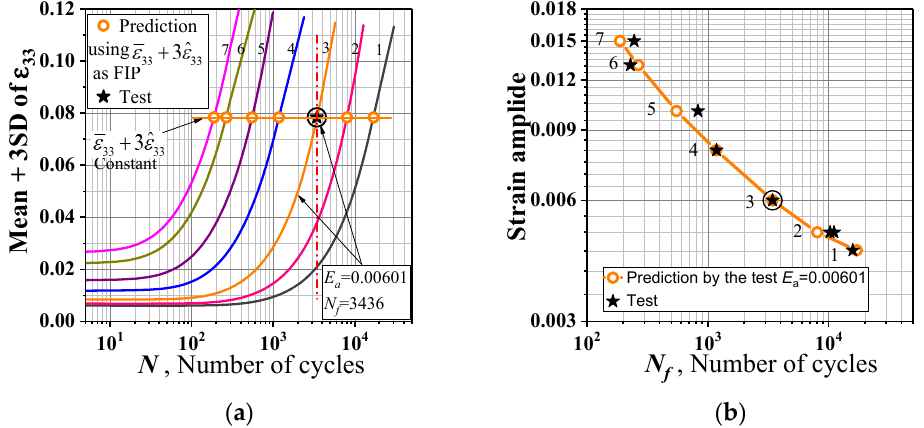
ε , by the intersection between curve of ˆ3 ε ε+ ( E = , by the intersection between curve of ε 33 + 3ˆ ε 33 33 33 33 33 a N E , by , E a ) , f f a ˆ3 0.078 ε ε+ = ; ( b ) predicted fa- 33 33 Test Upper prediction Lower prediction Prediction by the test E =0.00601 a